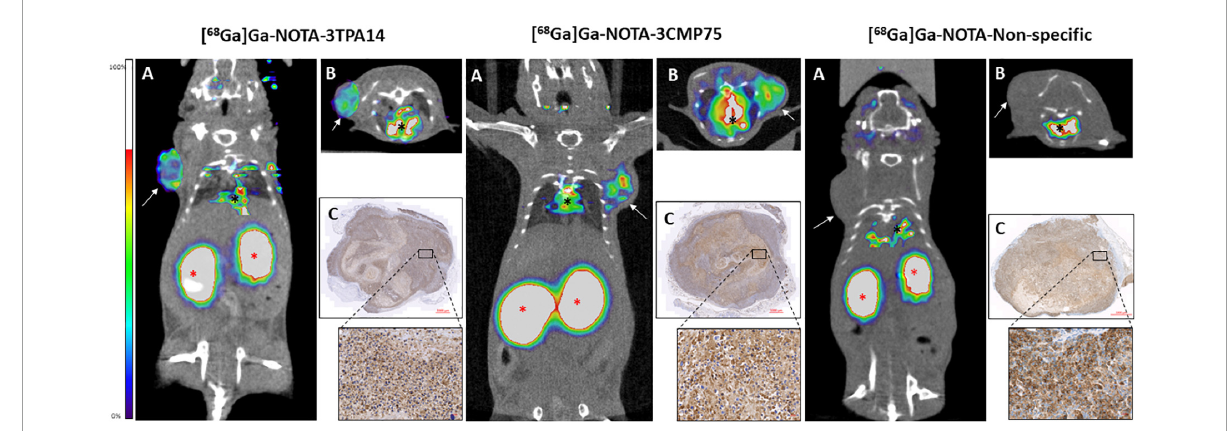
FIGURE6 PET/CT images of the different radiolabelled nanobodies [ 68 Ga]Ga-NOTA-3TPA14, [ 68 Ga]Ga-NOTA-3CMP75, and [ 68 Ga]Ga-NOTA-Non-specific performed in a triple-negative breast cancer (TNBC) mouse model showing their differences in tumoral uptake. Notice that the highest activity in tumour appears when PET-CT was performed with [ 68 Ga]Ga-NOTA-3CMP75 probe (central panel). White arrows pointed the breast tumours in each mouse. Red asterisks pointed the kidneys and black asterisks, the hearth. (A) Coronal view, (B) axial view, and (C) immunohistochemistry using anti MT1-MMP LEM 2/15 Ab with a close-up showing high MT1-MMP expression. Red scale bars: 1,000 µ m and close-up: 20 µ